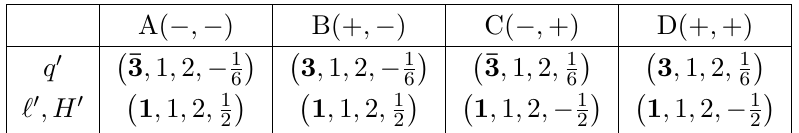
Table 2 . Doublet (cid:12)elds: the four possible SU(3) c Z 2 partners of q